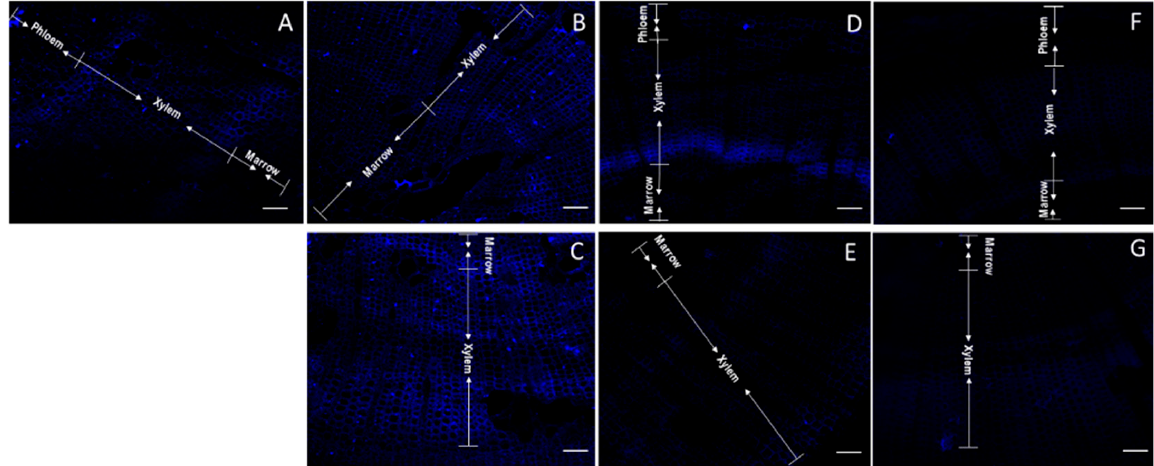
Figure 5. Confocal microscopy of thin sections of one year old radiata pine seedlings incubated with LM2 antibody and Alexa Fluor. Control stem (non-inclined) ( A ). Upper side of inclined stems after 2.5 h ( B ), 10 h ( D ) and 24 h ( F ). Lower side of inclined stems after 2.5 h ( C ), 10 h ( E ) and 24 h ( G ). Arrows indicate the section within the cuts corresponding to marrow, xylem and phloem. Scale of 100 µ m.